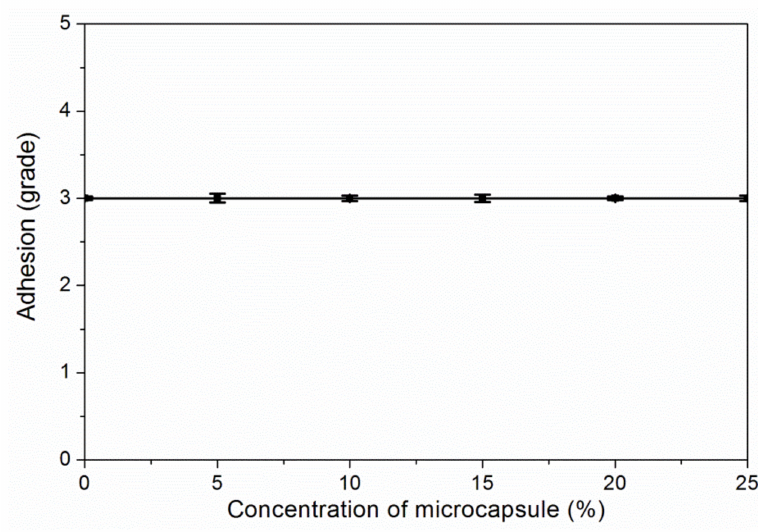
Figure 8. E ff ect of microencapsulation addition on the adhesion of waterborne coatings.